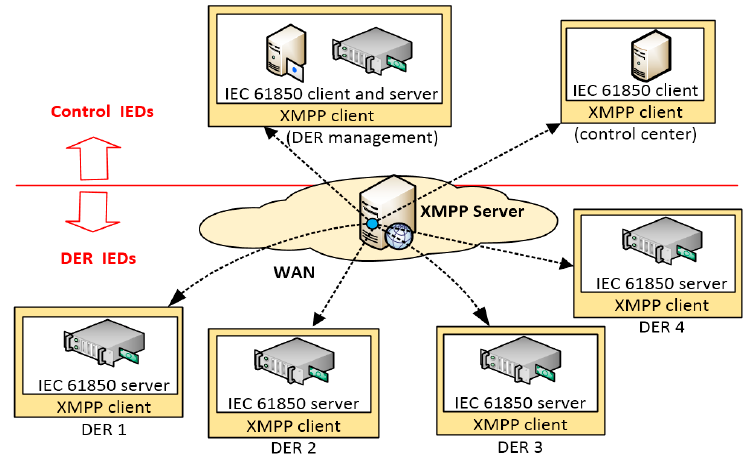
Figure 2. eXtensible Message Presence Protocol (XMPP) as middleware solution for the IEC 61850 based IEDs.